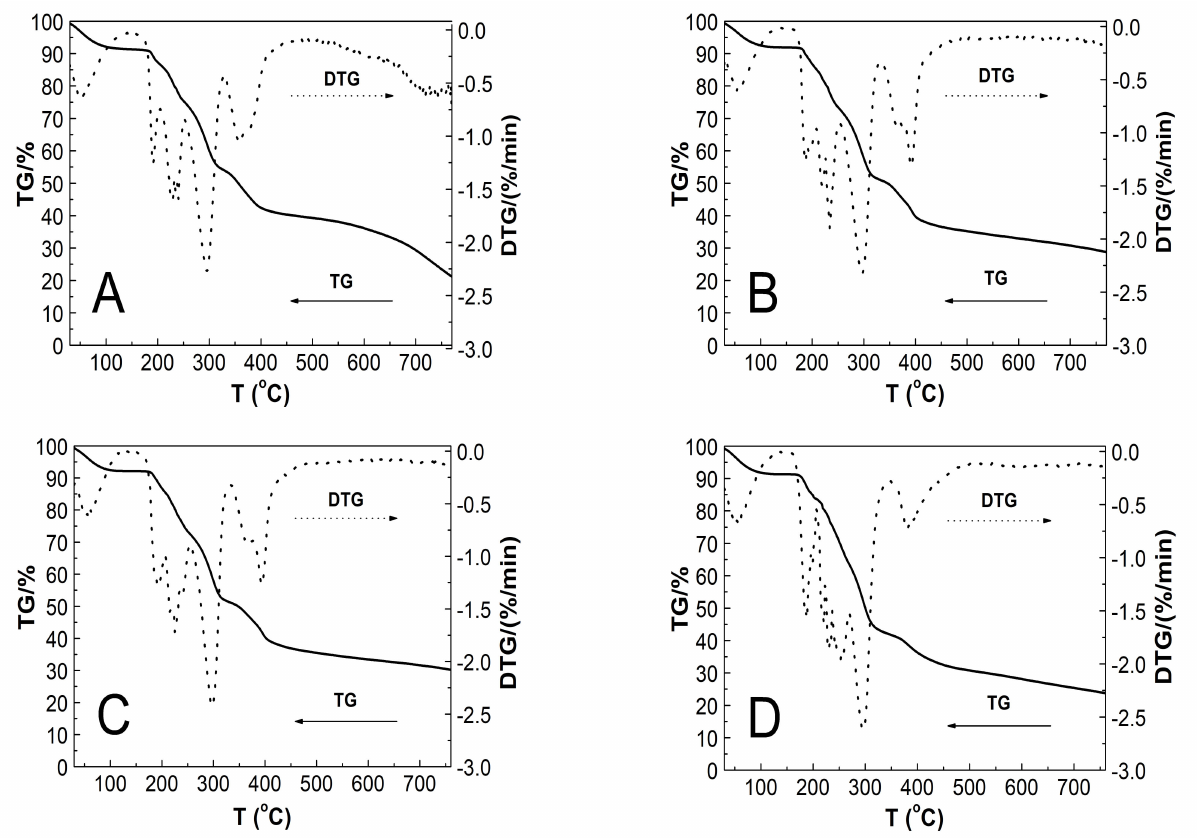
Figure 12. ( A – D ) TG—solid line, and DTG—dashed line, plots of weight loss (%) vs. temperature of polymers, PS1 ( A ), PS5 ( B ), PS3 ( C ), and PS4 ( D ). The heating rate was 5 ◦ C min − 1 in a nitrogen atmosphere at 50 mL min − 1 .